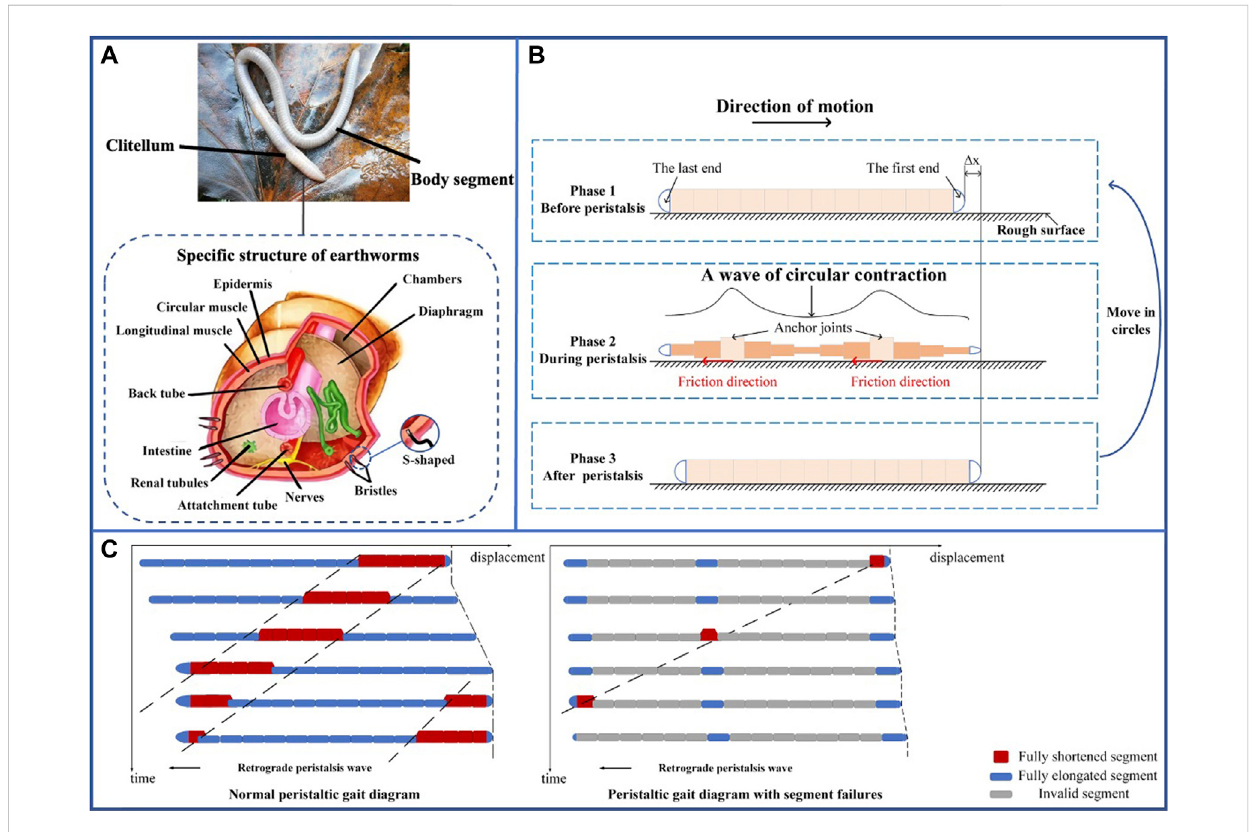
FIGURE 2 Structure andmotion ofearthworms. (A) Speci fi cstructureofearthworms. (B) Schematic ofearthwormmovementandmotion variation diagramof earthworm body segments. (C) Peristaltic gait diagram with or without segment